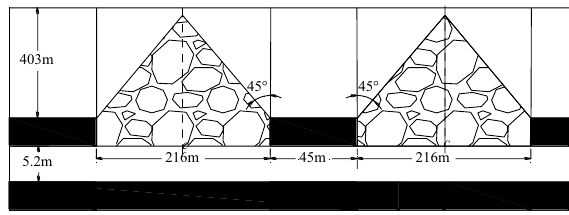
Figure 9. Schematic diagram of coal pillar load